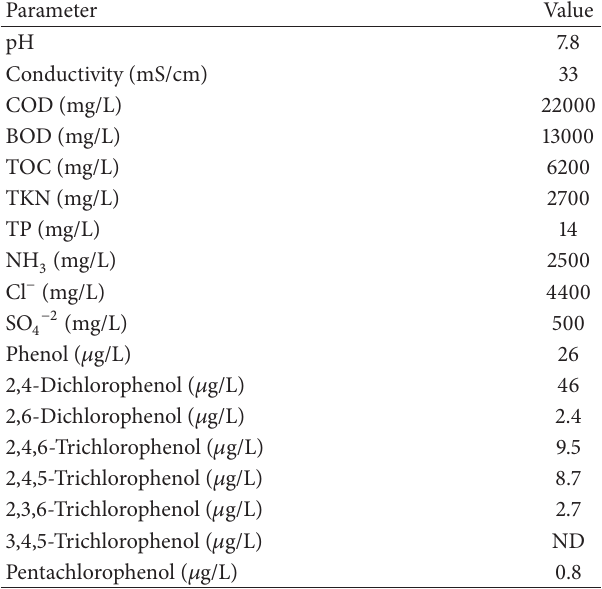
Table 1: Leachate